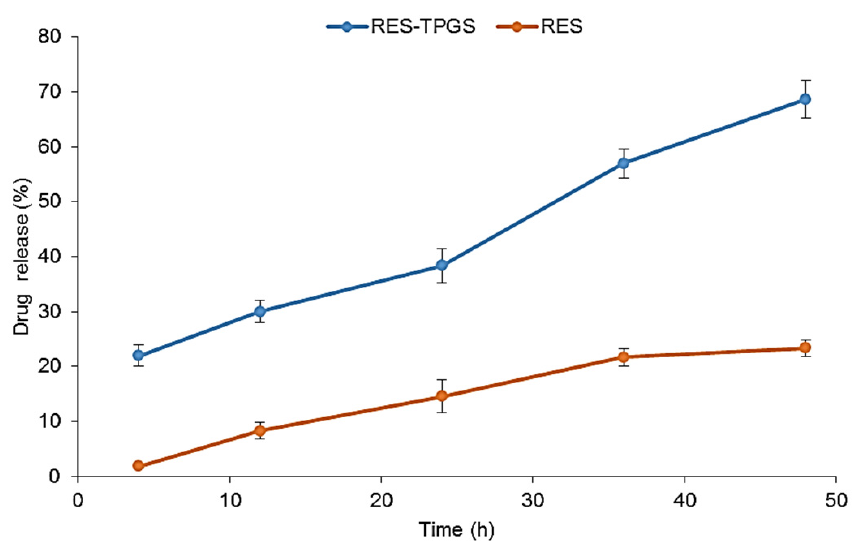
Figure 8. In vitro drug release % over time from the RES:TPGS 1:4 ( w / w ) formulation and an RES suspension in PBS at 37 °C.